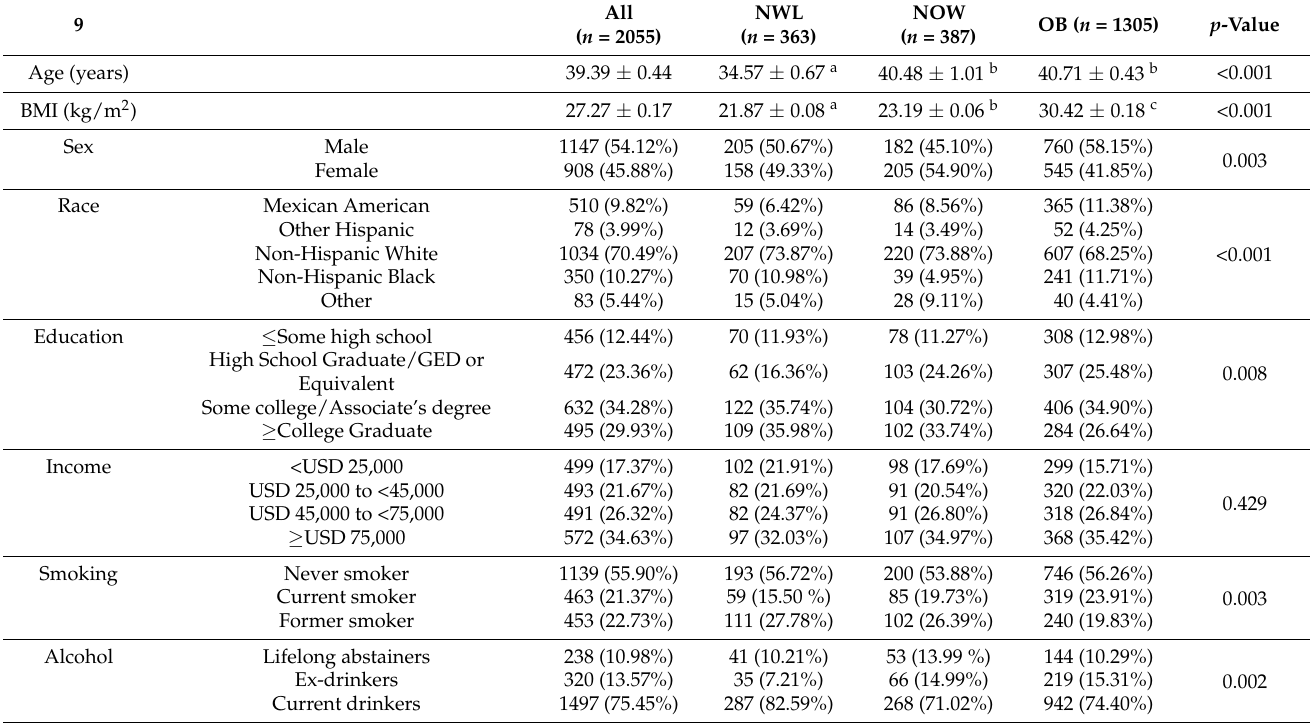
Table 1. Study participant